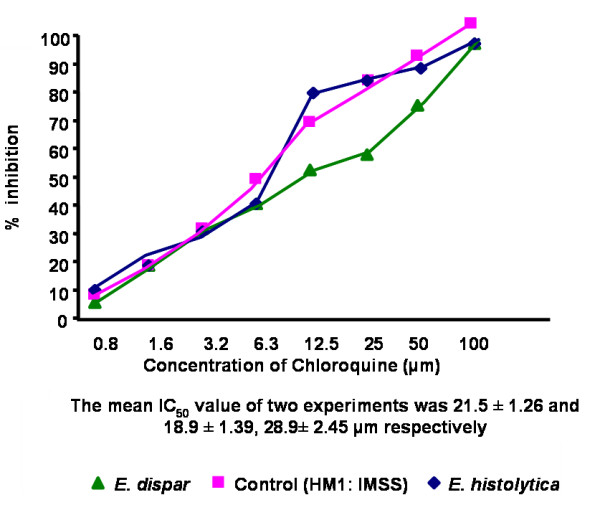
Percentage inhibition of E. histolytica (HM1: IMSS) and clinical isolates of E. histolytica and E. dispar by chloroquine